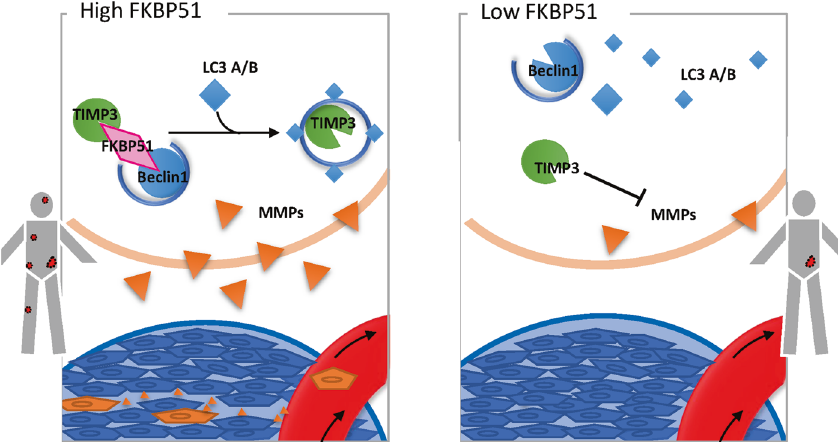
Fig. 8 Schematic model of the relationship among FKBP51 and TIMP3/MMPs in ccRCC. FKBP51 promotes ccRCC invasion and migration by downregulating TIMP3 through connecting TIMP3 with Beclin1 complex and upregulating the expression and functions of downstream